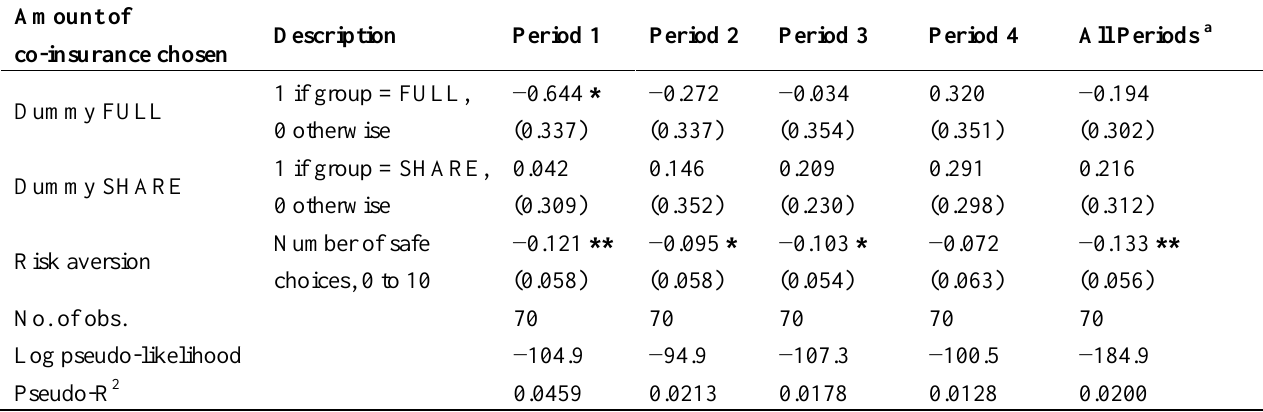
Table 5. Ordered probit estimation coefficients for co-insurance levels chosen.